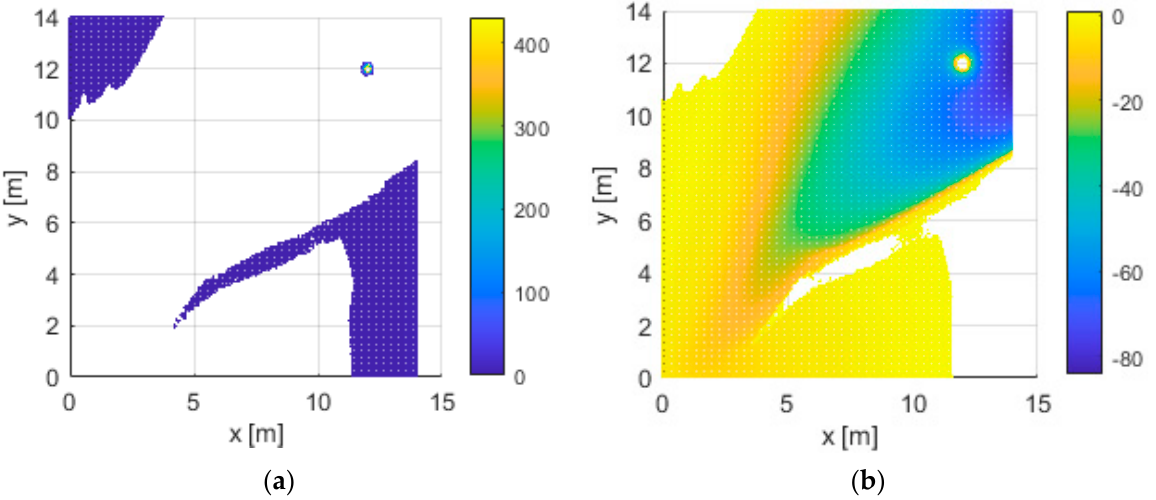
Figure 18. ( a ) Area of positive values obtained from the Lyapunov incremental function ∆𝐿 over the entire navigation surface for Agent J.; ( b ) Area of negative values obtained from the Lyapunov incremental function ∆𝐿 over the entire navigation surface for Agent J.